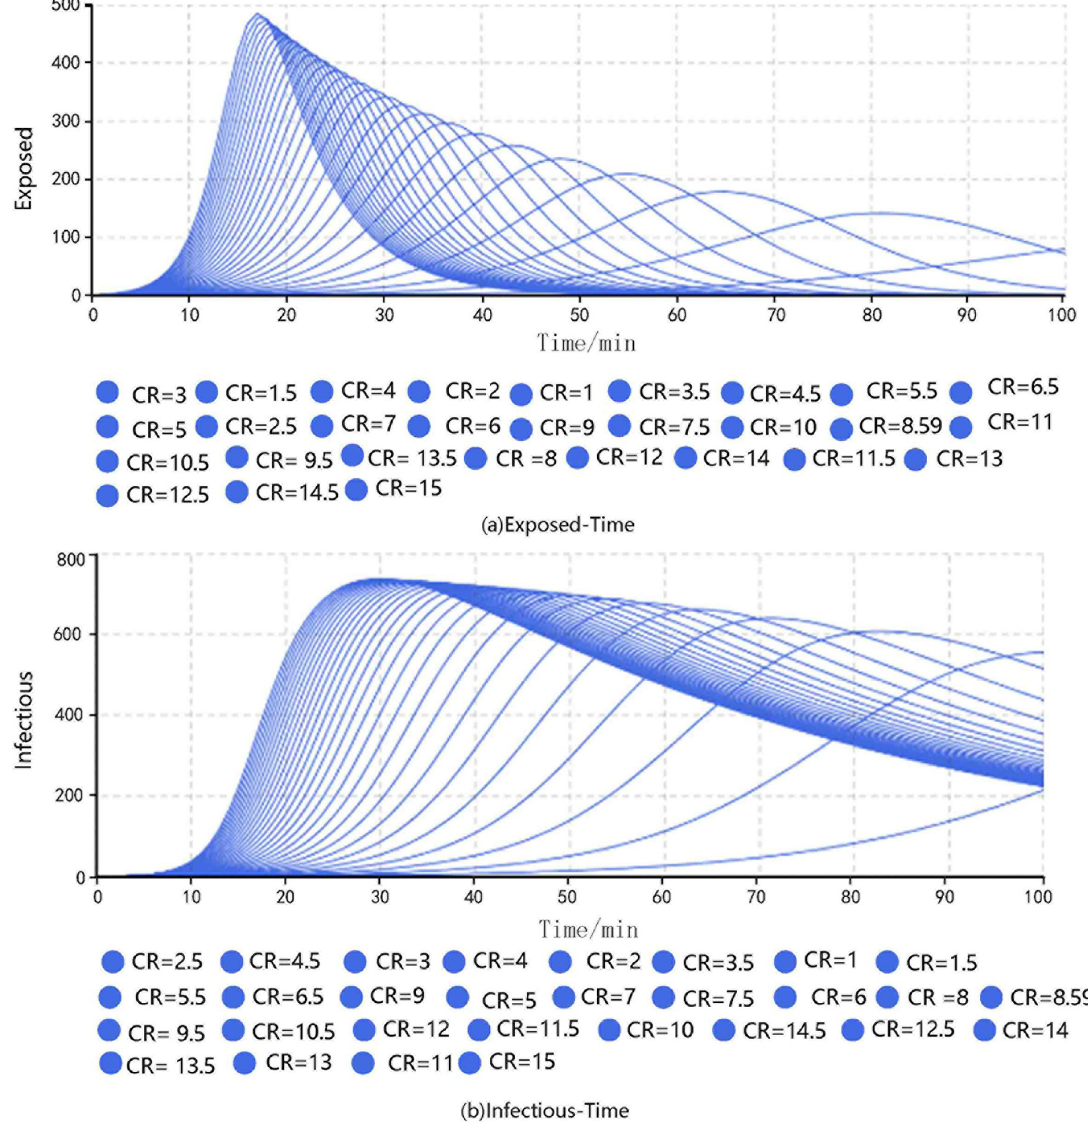
Fig 6. Exposure-infection curve under different contact rates.